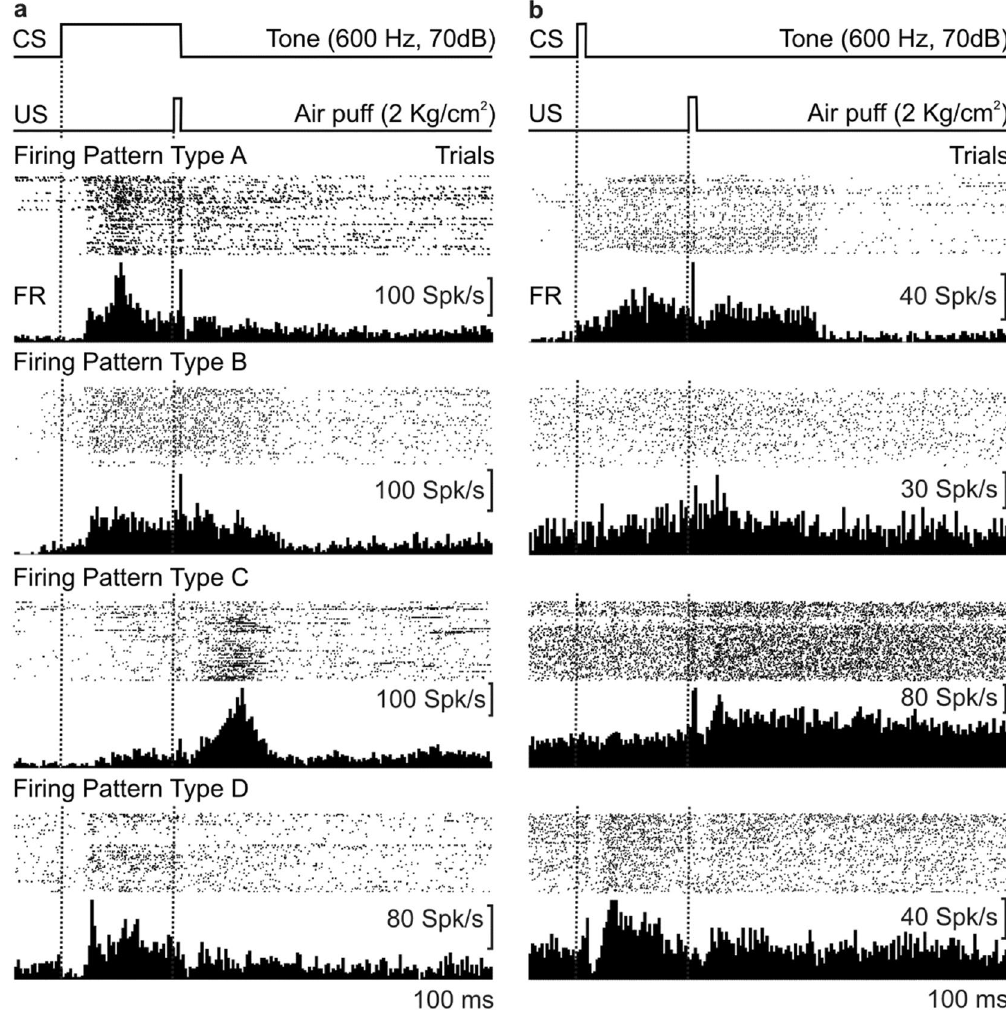
Figure 3. Different firing patterns of MC neurons activated during classical eyelid and Vib conditioning. ( a , b ) Firing patterns collected during delay ( a ) and trace ( b ) paradigms. From top to bottom are illustrated the CS– US presentations, the raster plot of spikes collected from MC neurons during a representative (n > 30) number of trials, and the averaged firing rate. Rasters and averages corresponded to the firing pattern of types A, B, C, and D of MC neurons. Type A firing pattern was characterized by an increased firing rate during the CR, and a noticeable decrease following US presentation. Type B firing presented an initial increased firing during the CR and a second increase during and after US presentation. Type C neurons presented a weak increase during the CR, reaching a maximum during and after US presentation, whereas Type D firing pattern decreased its basal rate after the beginning (delay), or brief duration (trace) of CS presentation, followed by a maximum peak, with a new decrease following the